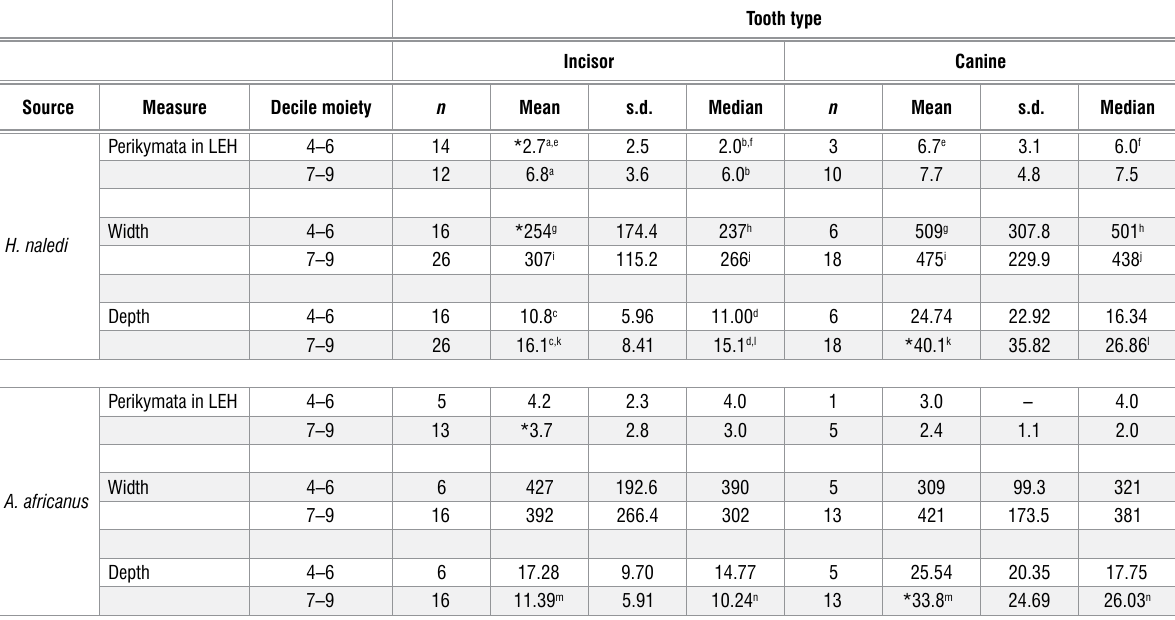
Descriptive statistics for anatomical variables of decile moiety and tooth type as they affect linear enamel hypoplasia (LEH; in µm); only statistically significant differences are